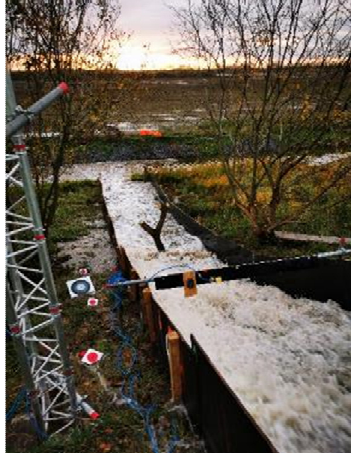
Figure 4. Anomaly test section with a tree trunk at the toe of the dike.